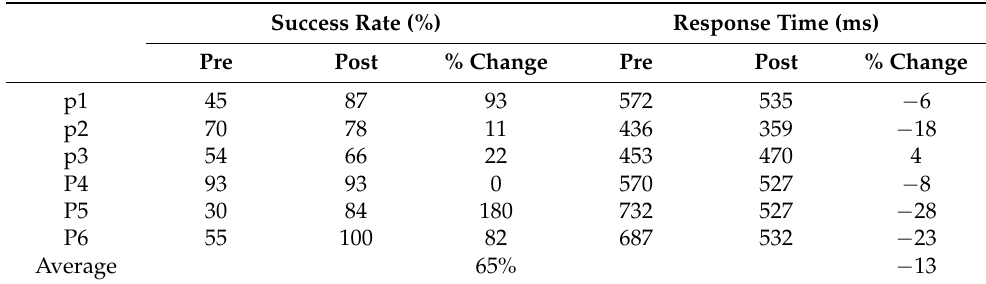
Table 3. Pre- and post-exercise test scores and percentage of change in soccer ball manipulation task for each child. Values are the average of forward and backward rolling game movements.